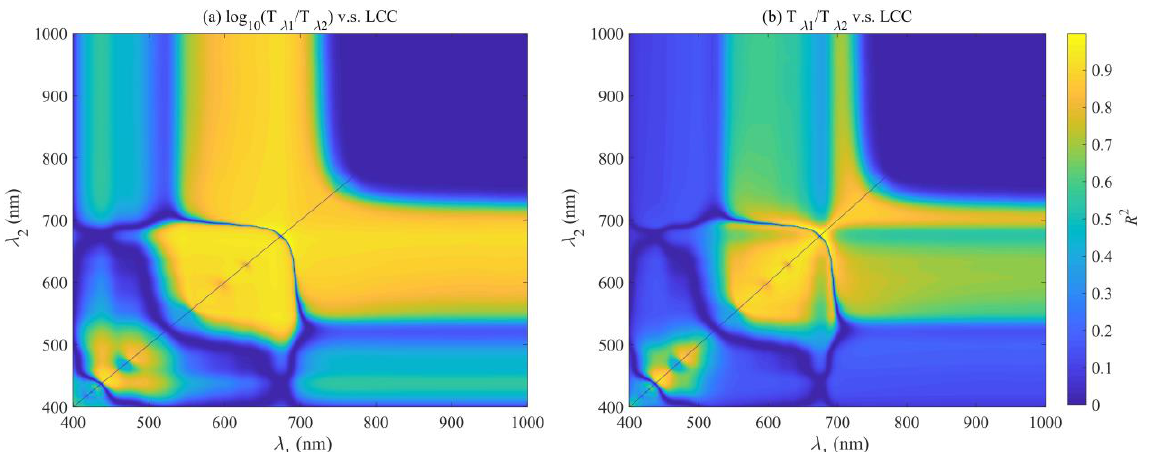
Figure 6. Variation in R 2 of relationships between the transmittance-based index and LCC, as a function of incorporated wavelengths, for log 10 (𝑇 𝜆1 /𝑇 𝜆2 ) ( a ), and 𝑇 𝜆1 /𝑇 𝜆2 ( b ).